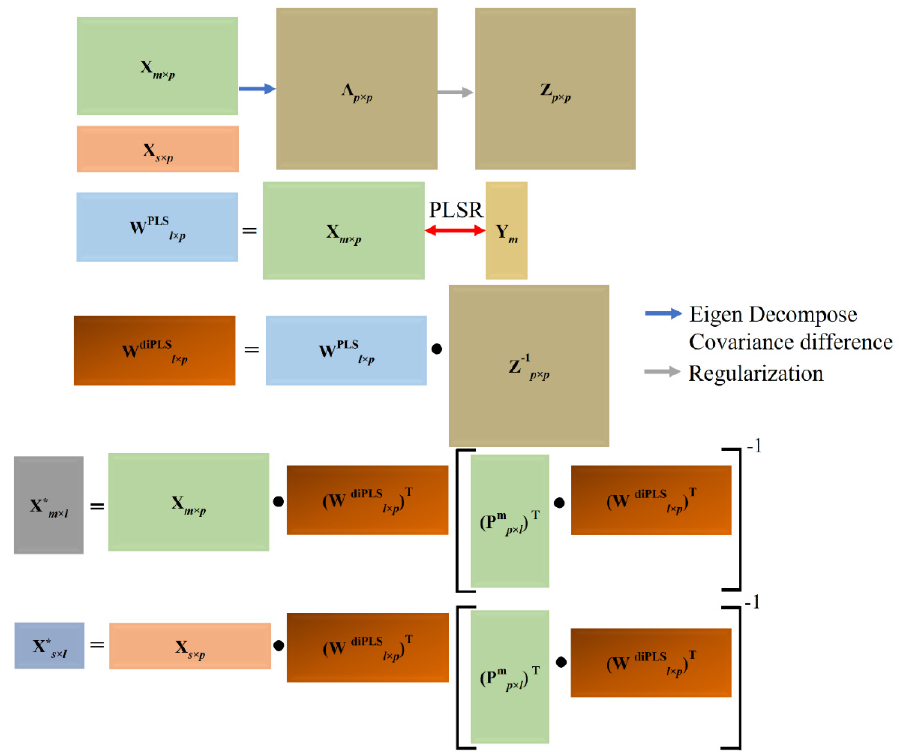
Figure 4. A schematic to illustrate the working principle of di-PLSR (here, m = n m and s = n s ).